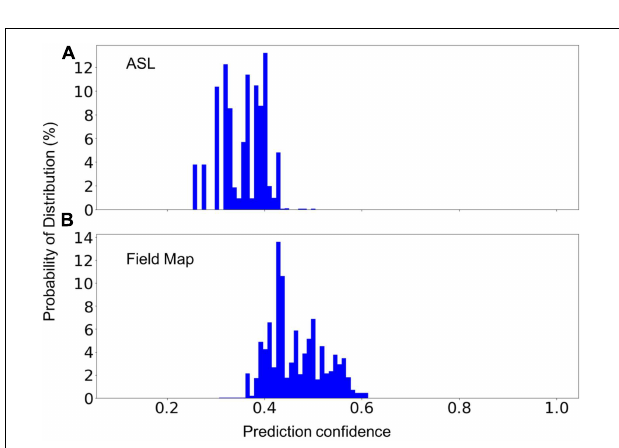
FIGURE 5 | The percent distribution of the classification confidence on predicting two unknown classes, (A) Arterial Spin Labeling (ASL), and (B) Field Map scans. The random forest models are built from 1,200 scans from each of the sequence types 1–7 listed in Table 2 . The data are collected from 20 separate computations.